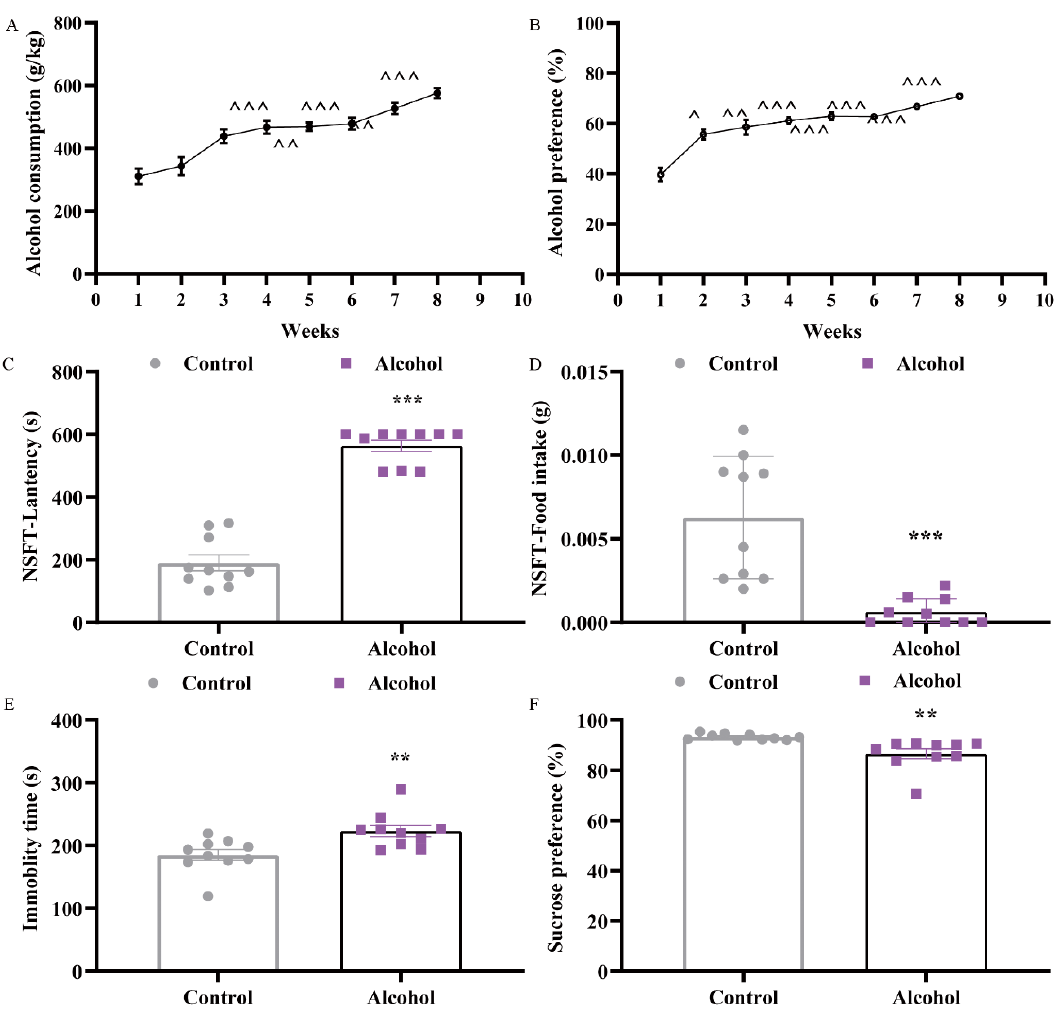
Figure 1. Alcohol exposure induced depressive-like behaviors in mice. ( A ) Alcohol consumption in mice across 8 weeks of alcohol, ( B ) alcohol preference in mice across 8 weeks of alcohol, ( C ) immobility time of mice in tail suspension test, ( D ) latency to feed in novelty-suppressed feeding test, ( E ) the food intake in novelty-suppressed feeding test, and ( F ) the sucrose preference of mice in sucrose preference test. Data are presented as the mean ± SEM, and one-way repeated measures ANOVA was performed for alcohol consumption and preference data with Sidak’s post hoc test. n = 10 for per group, ^ p < 0.05, ^^ p < 0.01, ^^^ p < 0.001 compared with week 1. Student’s t test was applied to other animal experiments, ** p < 0.01, *** p < 0.001 vs. control group. The open field test (OFT) and zero maze test (ZMT) were performed to measure anxiety-like behaviors. Compared with the control group, the times of central area entry of mice were clearly reduced (t = 7.235, p < 0.0001) (Figure 2A). Mice in the alcohol group, on the other hand, spent significantly less time in the open field’s middle section (t = 5.225, p < 0.0001) (Figure 2B). In the ZMT, the alcohol group had remarkably less entries and spent much less time in the open arms than the control group (t entry = 5.084, p < 0.0001; t time = 3.829, p = 0.0012) (Figure 2C,D). These data implied that alcohol exposure led to depressive and anxiety-like